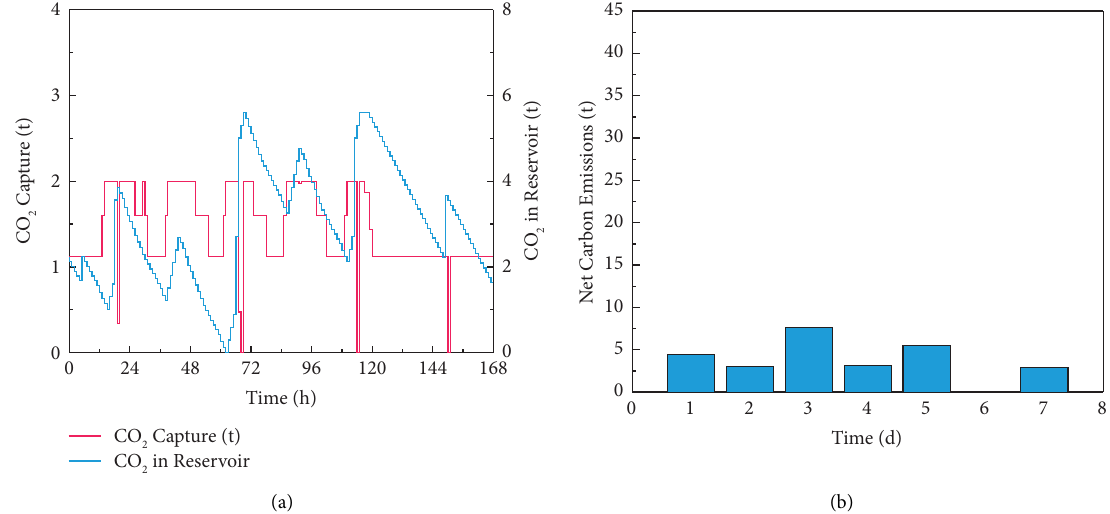
2 in reservoir. (b) Net carbon